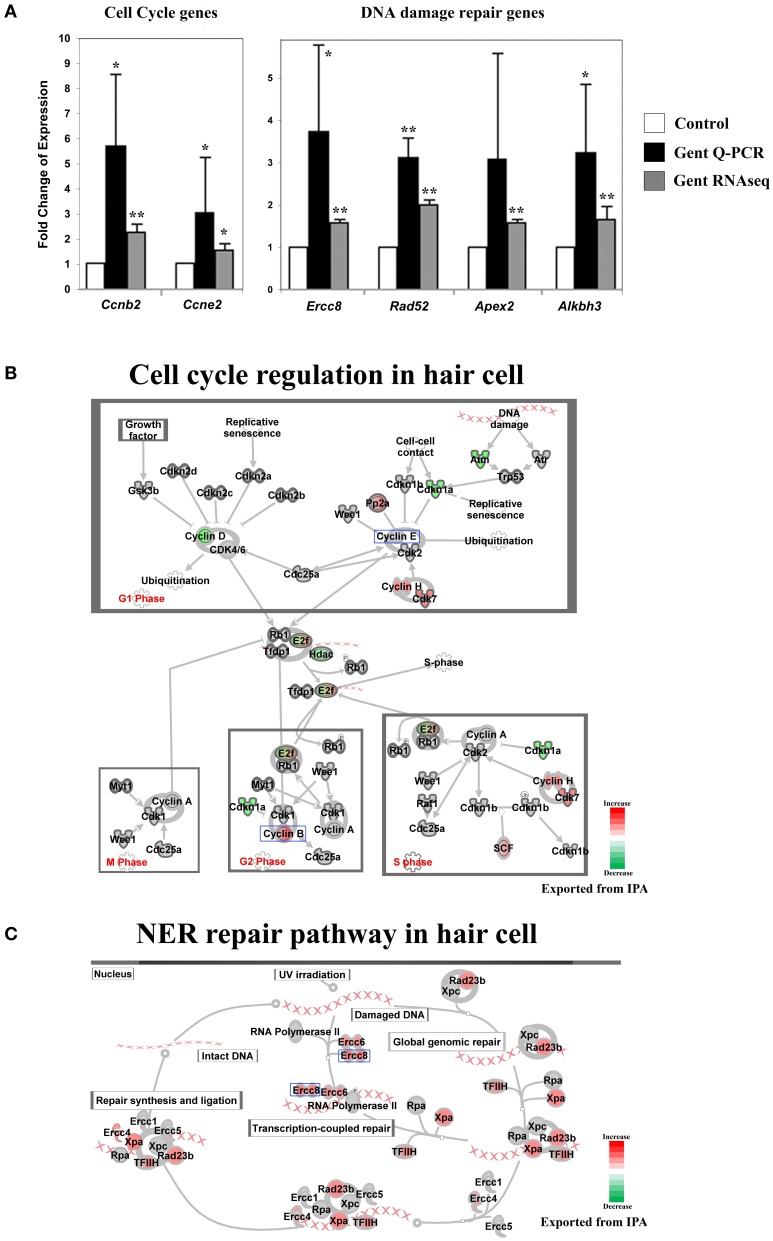
Gentamicin-induced changes in expression of genes involved in cell cycle and DNA damage repair. (A) Q-PCR results validating increased messenger RNA levels of selected genes in hair cells after gentamicin treatment. These results confirm the up-regulation of cell cycle and DNA damage repair genes in gentamicin-treated hair cells. Error bar, standard deviation: *p < 0.05; **p < 0.01. (B) Cell cycle regulation network with color-coded expression changes suggesting affected cell cycle gene regulation by gentamicin. (C) Nucleotide excision repair (NER) network with color-coded expression changes showing significant induction of NER genes. Only genes with significant expression changes are colored. Red, increased expression; green, decreased expression relative to control; half red-half green, indicates nodes with multiple genes with some genes upregulated and some genes downregulated. Genes validated and discussed in the text are boxed in the corresponding protein pathway diagrams.